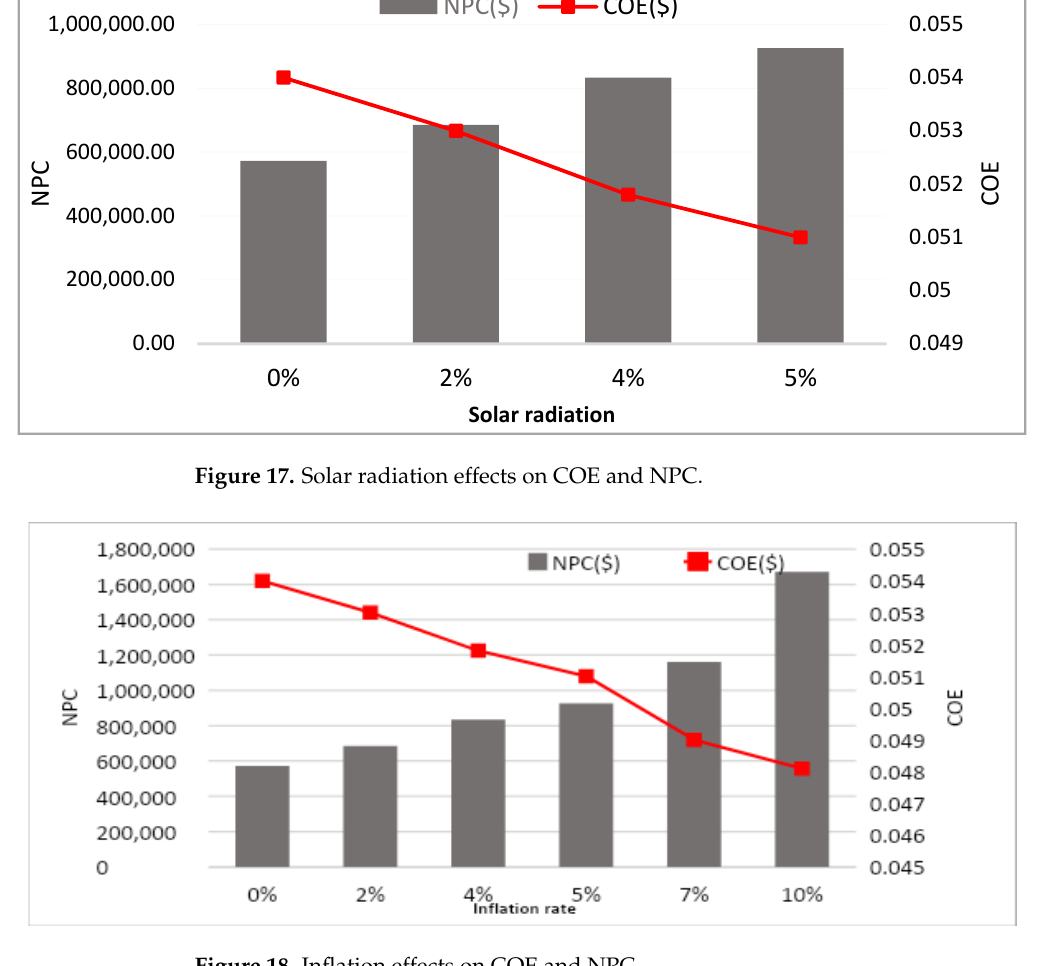
Figure 18. Inflation effects on COE and NPC.